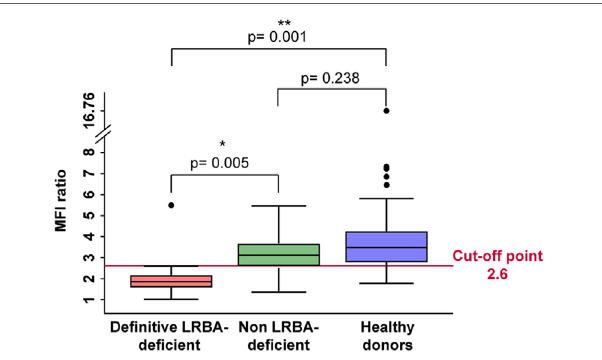
FIGURe 5 | LRBA deficient patients have significantly reduced mean fluorescence intensity (MFI) ratio of LRBA expression in peripheral blood mononuclear cells compared to healthy donors. Boxplot analysis showed that definitive LRBA deficient- patients represented in red, have significantly reduced MFI ratio of LRBA expression compared to healthy donors represented in blue ( p = 0.001) and to non-LRBA deficient patients represented in green ( p = 0.005). Each value bigger or smaller than this range is marked as a black dot.